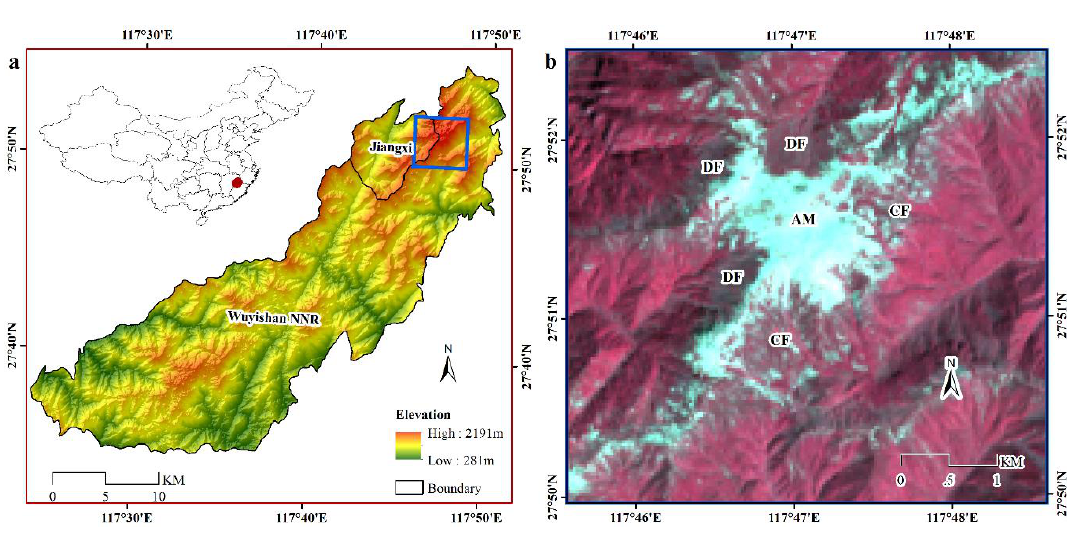
Figure 2. Study area. ( a ) Elevation map of Wuyishan National Nature Reserve (NNR — one part of Wuyishan National Park) and digital elevation model (DEM) from ASTER (Advanced Spaceborne Thermal Emission and Reflection Radiometer) Global Digital Elevation Model V002. ( b ) Close-up of blue box in ( a ): vegetation communities related to the tree line ecotone, including alpine meadow (AM), dwarf forest (DF), and coniferous forest (CF). Background image is a Landsat 8 scene acquired on 28 March 2016, with a standard false-color composition (near-infrared band in red, red band in green, and green band in blue).